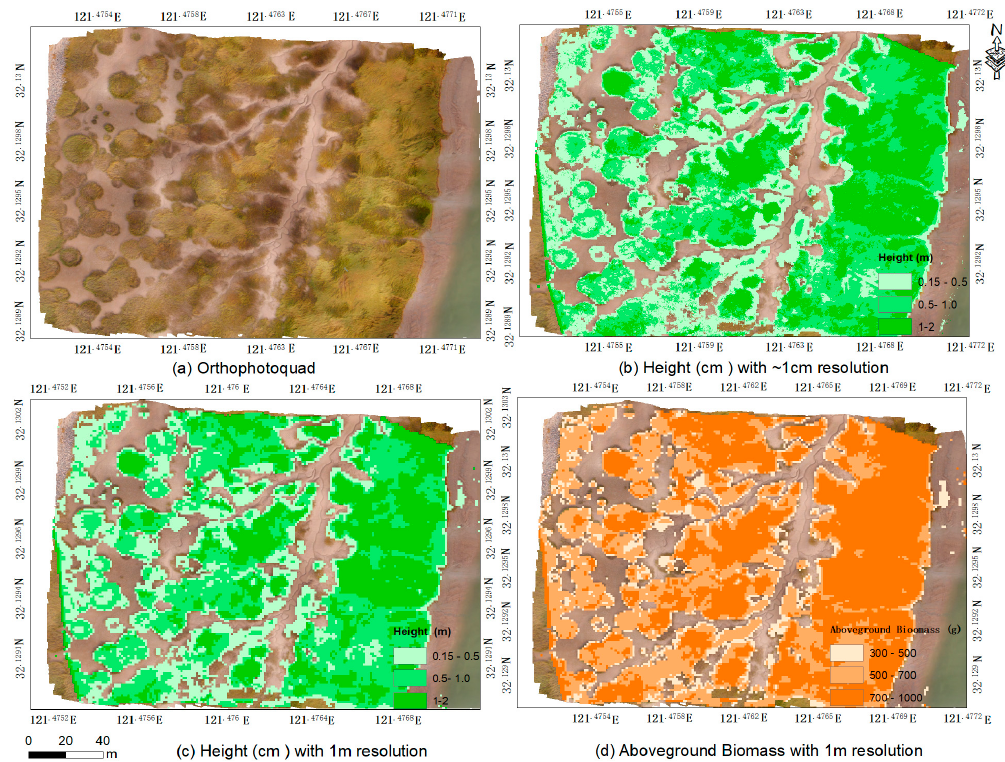
Figure 13. The UAV orthophotoquad image of the spatial distribution of Spartina alterniflora in the Jiangsu study site ( a ); the height distribution map with ~1 cm resolution ( b ); the resampling height distribution map with 1 m resolution ( c ); and the inversed aboveground biomass distribution map ( d ).